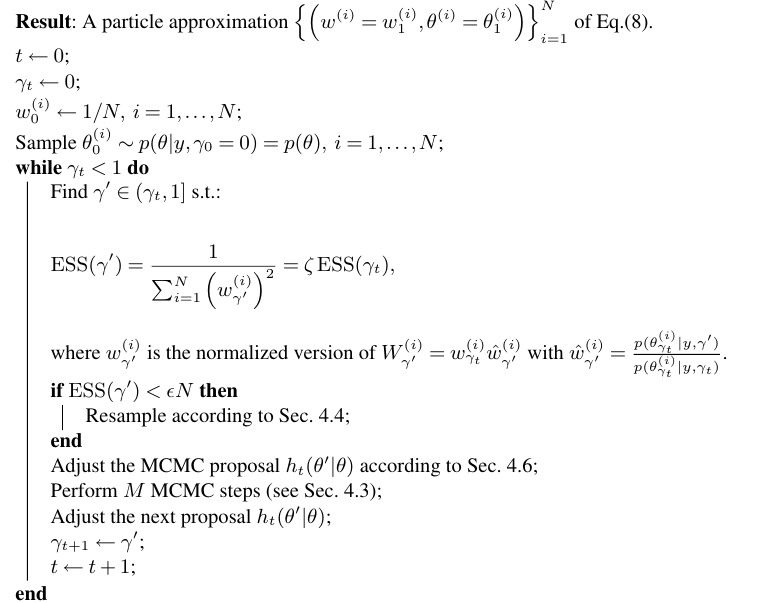
Algorithm 1: Sampling from the posterior using sequential Monte Carlo. Algorithm 1. Sampling from the posterior using sequential Monte Carlo.